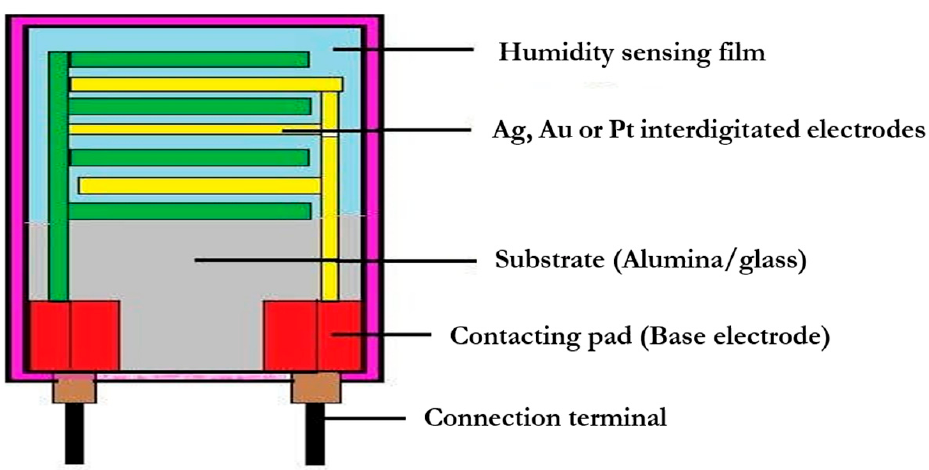
Figure 5. Configuration of a resistive humidity sensor .